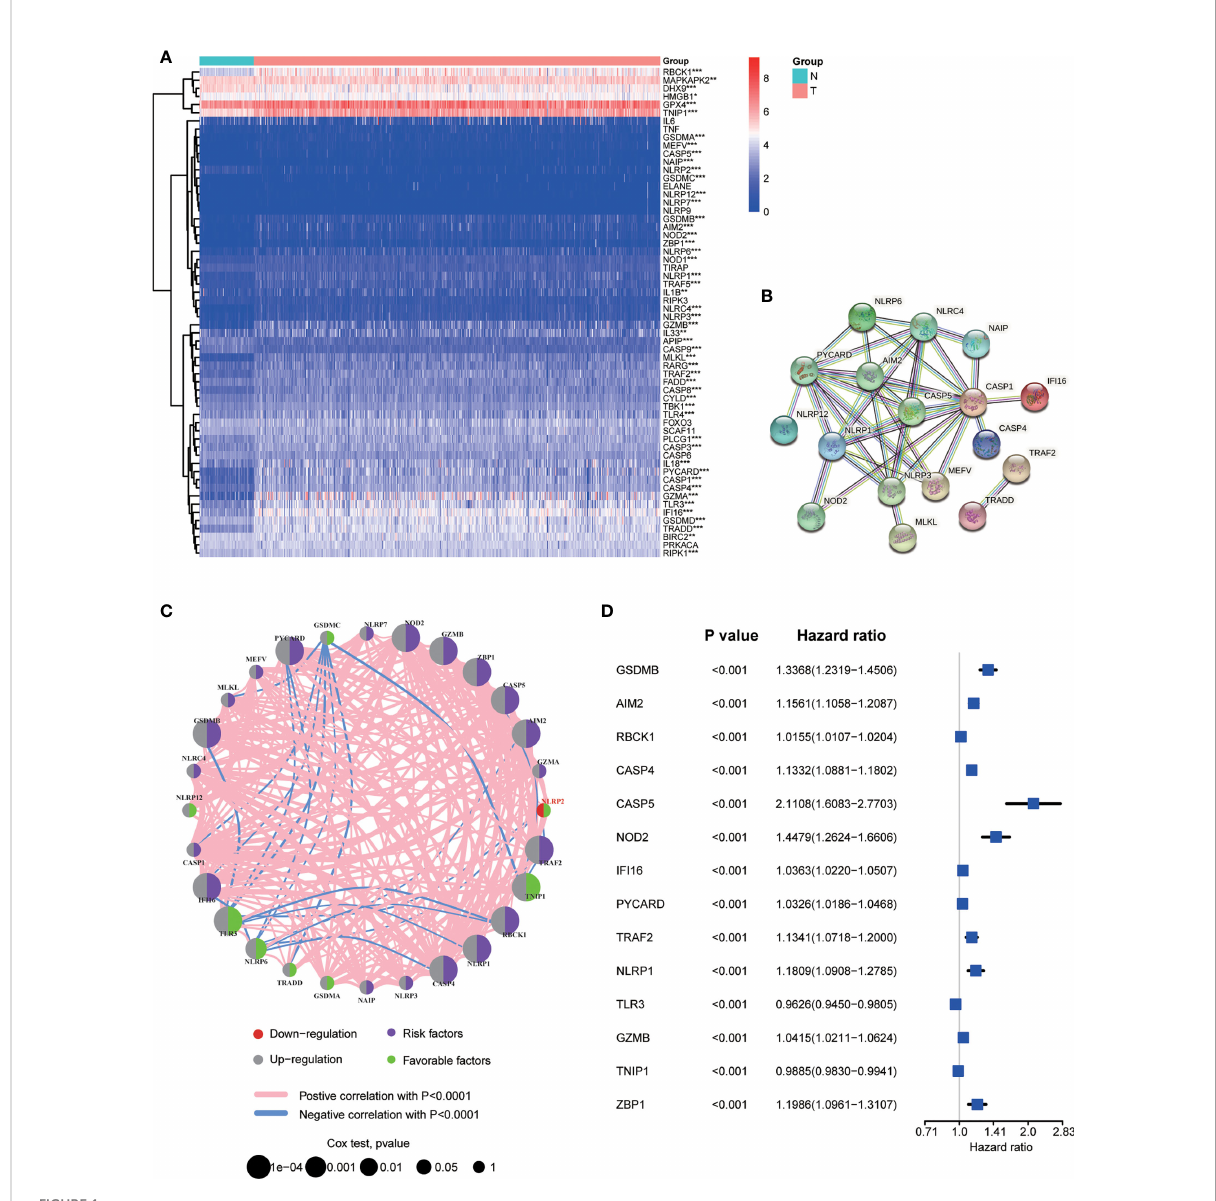
FIGURE 1 Screening necroptosis and pyroptosis related genes (NPRGs) in ccRCC. (A) Heat map of 60 NPRGs. (B) PPI network for the cross talks of NPRGs according to STRING database (cross talk score = 0.9). (C) The association network landscape of differentially Expressed NPRGs (DE-NPRGs): red dot, down-regulation; grey dot, up-regulation; purple dot, risk factors; green dot, favourable factors; pink line, positive correlation with P < 0.001; blue line, negative correlation with P< 0.0001; the size of dots represents the signi fi cance of the correlation. (D) Univariate Cox regression analysis of candidate NPRGs with the 14 ones were signi fi cantly selected in the model (P <